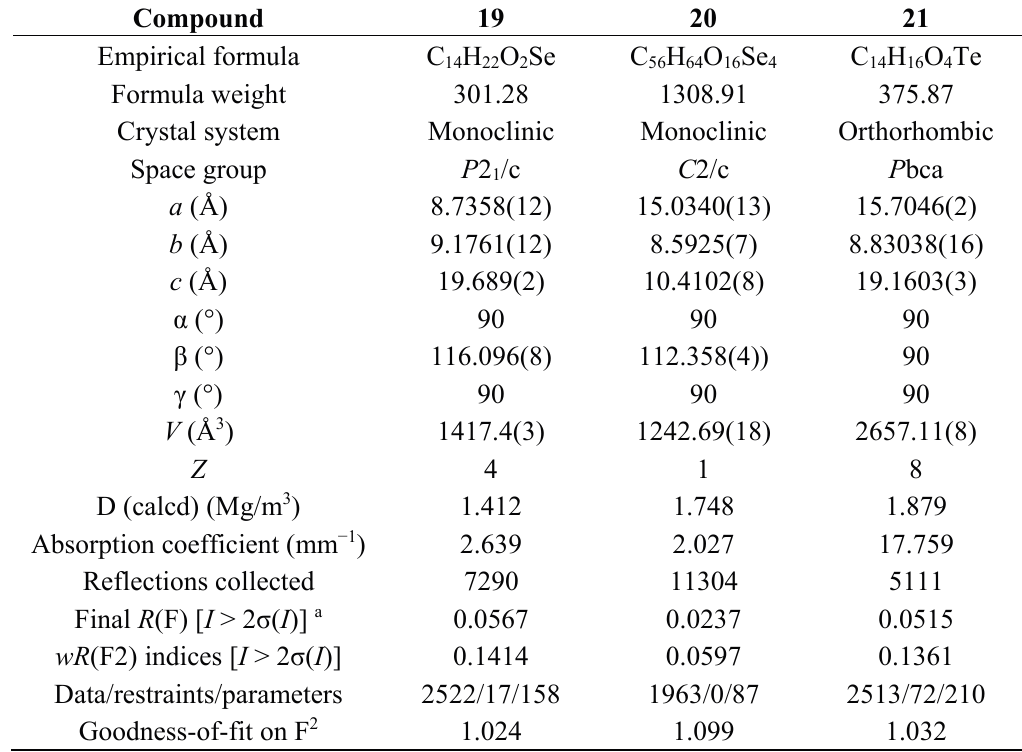
Table 2. Crystal and structure refinement data for 19 – 21